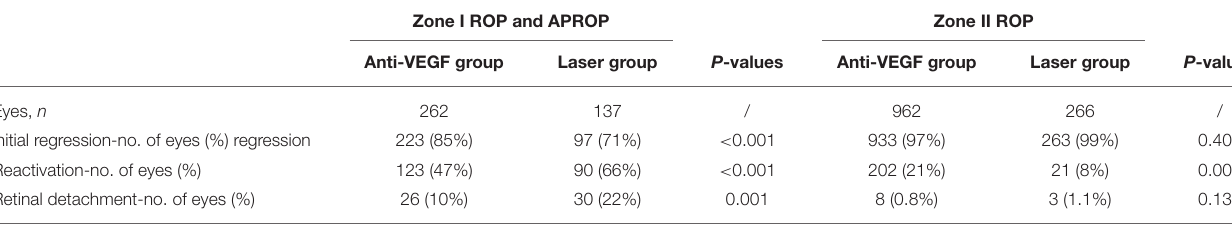
TABLE 2 | The comparison of efficacies and treatment outcomes.